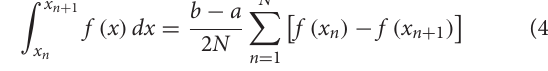
the “metric.hausdorff” function in the fda.usc R software package (28). Prior to calculating the Hausdorff distance, the x and y screen coordinate points of the reference spiral were interpolated to the length of the cohort’s drawing’s coordinates using cubic spline interpolation (29–31). Several Hausdorff distance-related features were then calculated (e.g., maximum of Hausdorff distance, interquartile range of Hausdorff distances, etc.). All Hausdorff distance related features are provided in Table 3